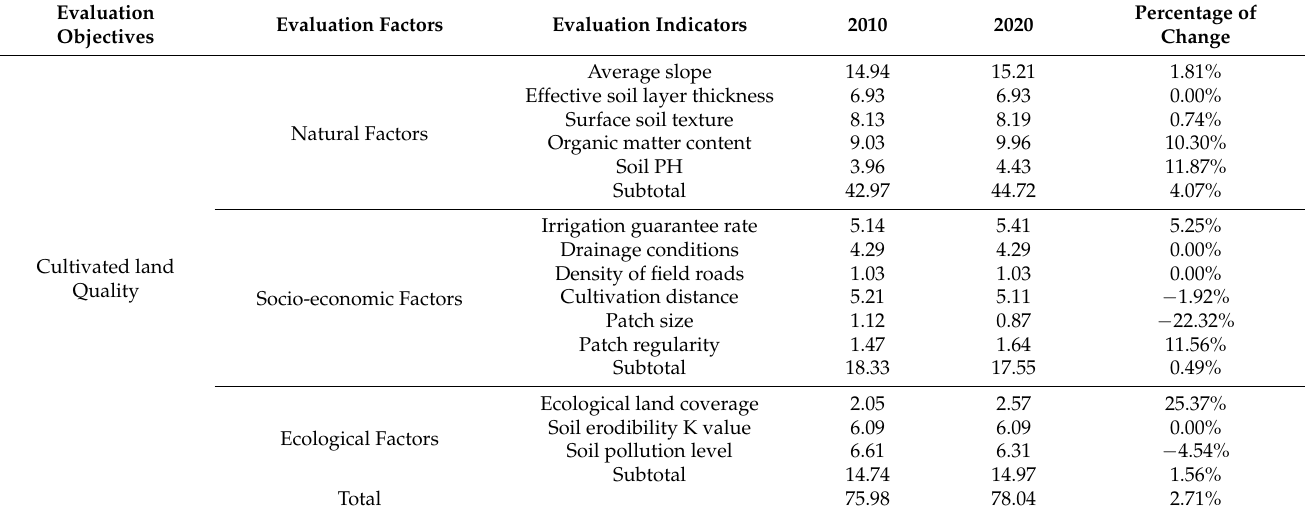
Table 6. Comparison of average scores of evaluation indicators for cultivated land,